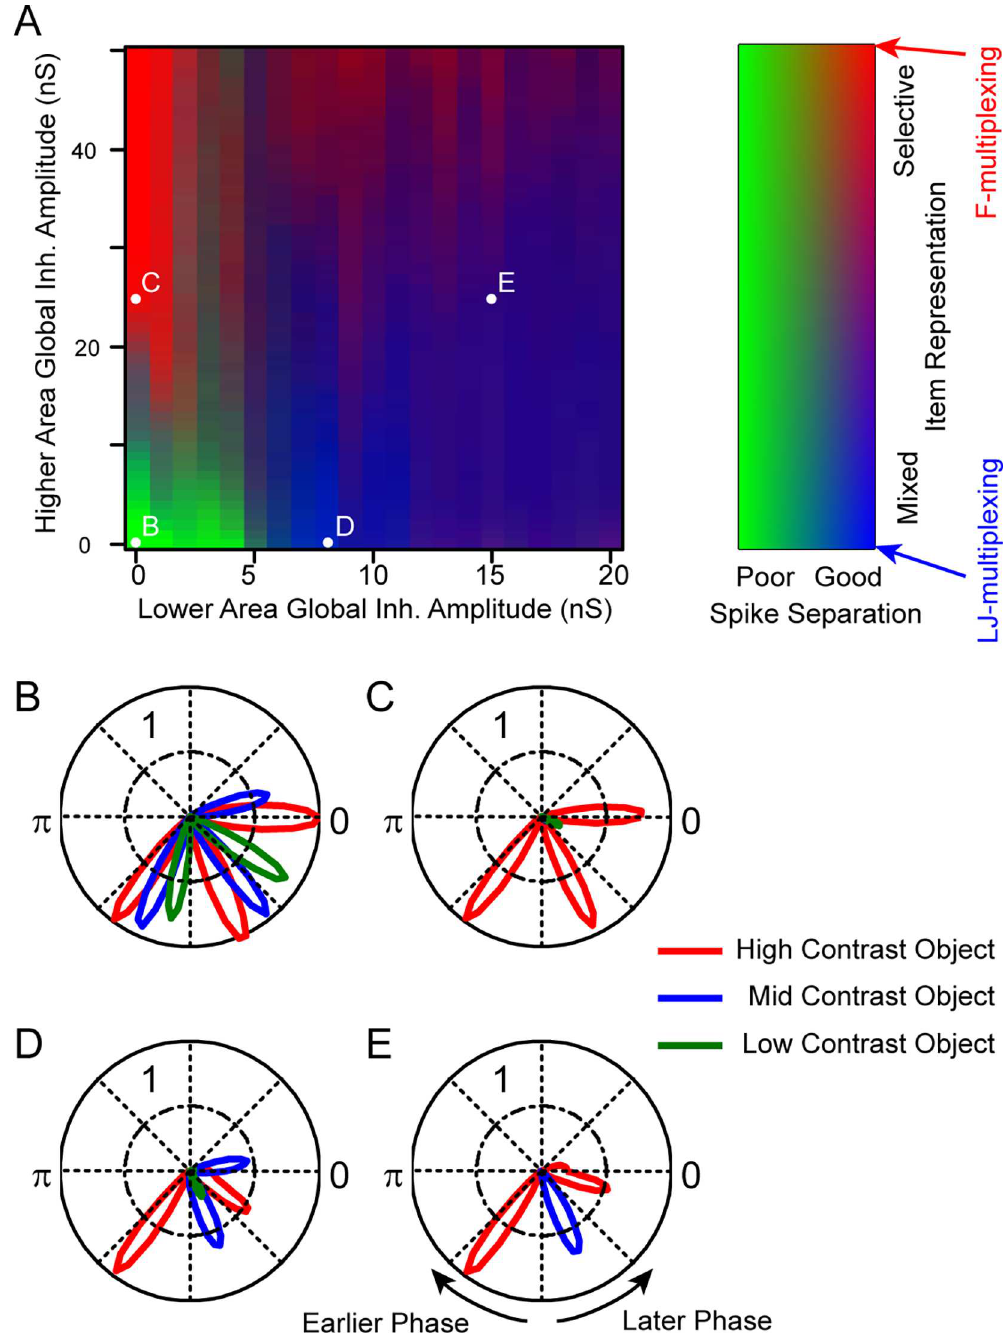
Fig 3. Network states as a function of global inhibition amplitude in the lower and higher area. A. The colour map shows the network state dependenceon parameter values (other parametersset to default values except as stated, 5 repeats of 2 seconds of simulated activity for each condition), with green reflecting poor spike separation,red selective representation of a single item (F-multiplexing), and blue alternationbetween different items (LJ-multiplexing);see Methods for details of the indices used to measure spike separationand item representation. B–E. Polar plots of higher level activity, spike probability(across simulation repeats) as a function of slow oscillationphase. Colours (red, blue and green) indicate spikes driven by the high, mid and low contrast objects respectively. The different plots correspondto the different network states, as marked in panel A. B. Without global inhibitionin either area, all items were represented but there was poor spike separation(green area in A). C. With global feedback inhibition only in the higher area, the network displayedF-multiplexing, with a